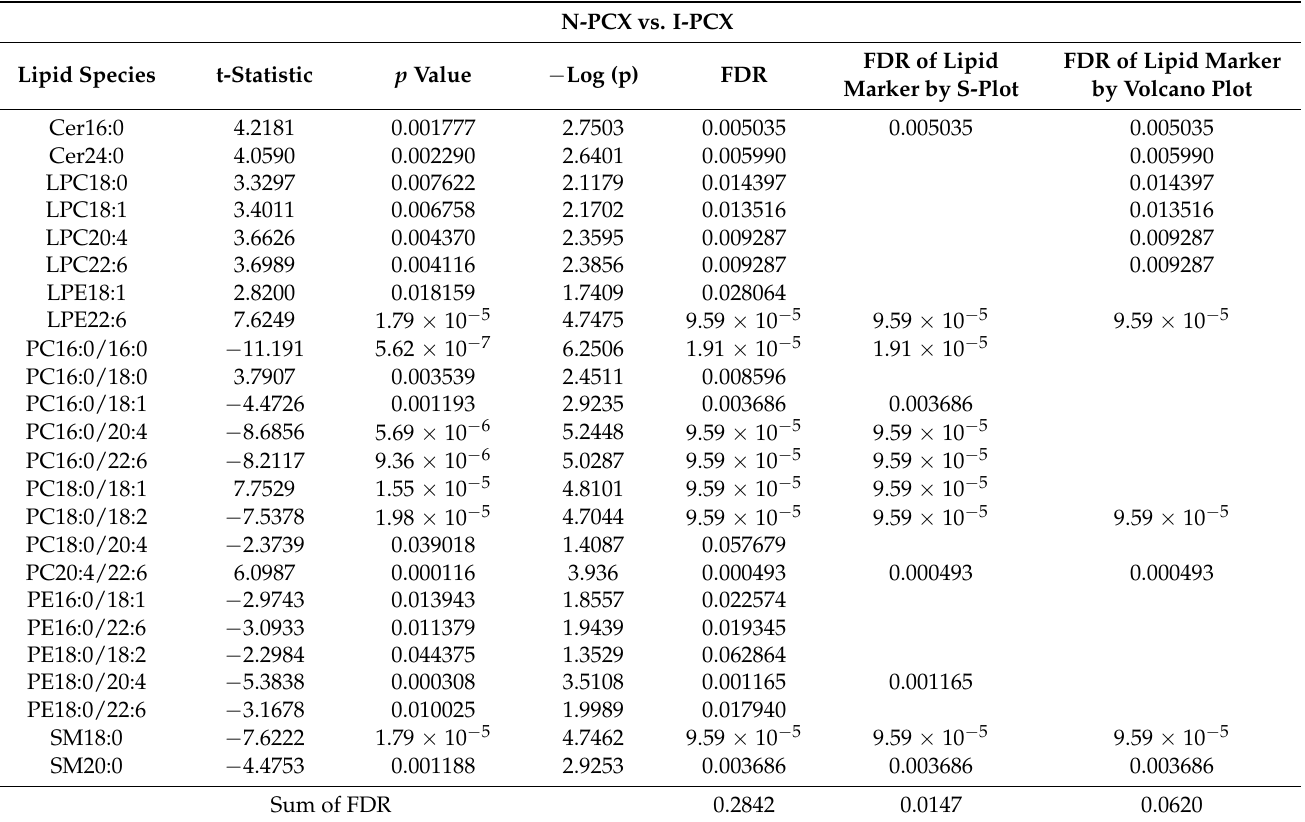
Table 4. List of lipid species showing statistical significance ( p < 0.05) between I-PCX and N-PCX (N = 6 each, unpaired t -test), with their t-statistic, p value, − log(p), false discovery rate (FDR) of each listed lipid species, the sum of FDR from all listed lipid species, (the FDR column), from S-plot of OPLS-DA-identified markers, and from volcano-plot-identified markers. N-PCX vs. I-PCX